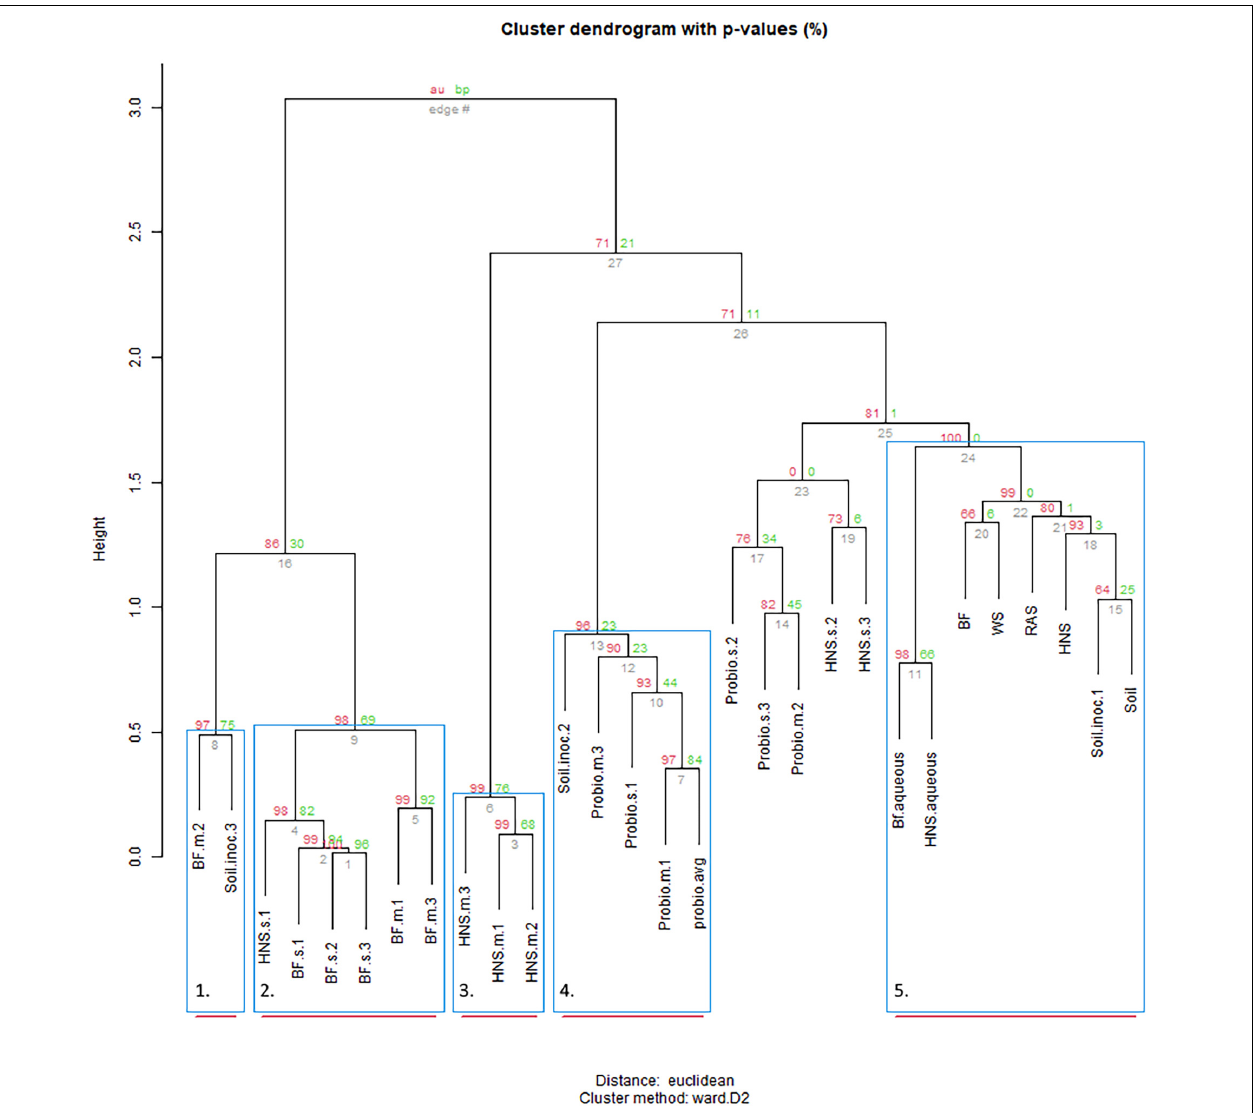
FIGURE 2 | Cluster dendrogram of the distribution of microbial communities at the genus rank across treatments with the five most robust clades highlighted. Similar patterns were observed at higher ranks. Treatments include hydroponic nutrient solution sump (HNS) and biofilter effluent sump (BF) under mature (.m), sterilized (.s), and basin water column (.aqueous) conditions. Additionally, soil inoculum (Soil) and HNS inoculated culture (soil) and probiotic (probio) inoculated sterilized (.s) and unsterilized biofilter effluent (BF) samples, as well as the facility water source (WS) and recirculating aquaculture system water column (RAS) are also